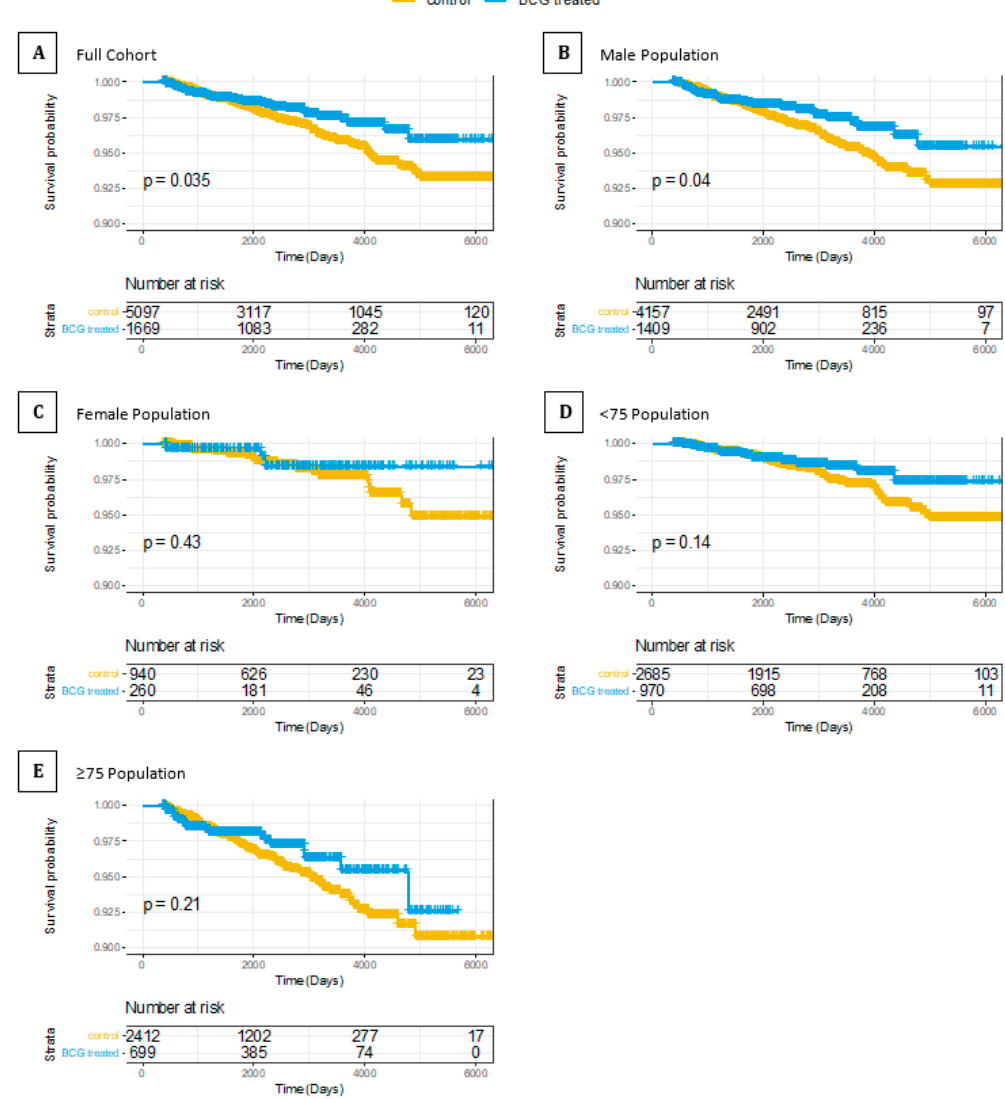
Figure 3. KM survival curve of bladder cancer patients treated or not treated with BCG, examined for PD risk. The whiskers on the KM survival plots represent the censored patients. ( A ) Full CHS cohort; ( B ) male only; ( C ) female only; ( D ) <75 population. ( E ) ≥ 75 population. Table 4. Risk assessment of PD in CHS by Kaplan–Meier (KM), Cox proportional hazards regression (Cox), and competing risk analysis (CR).